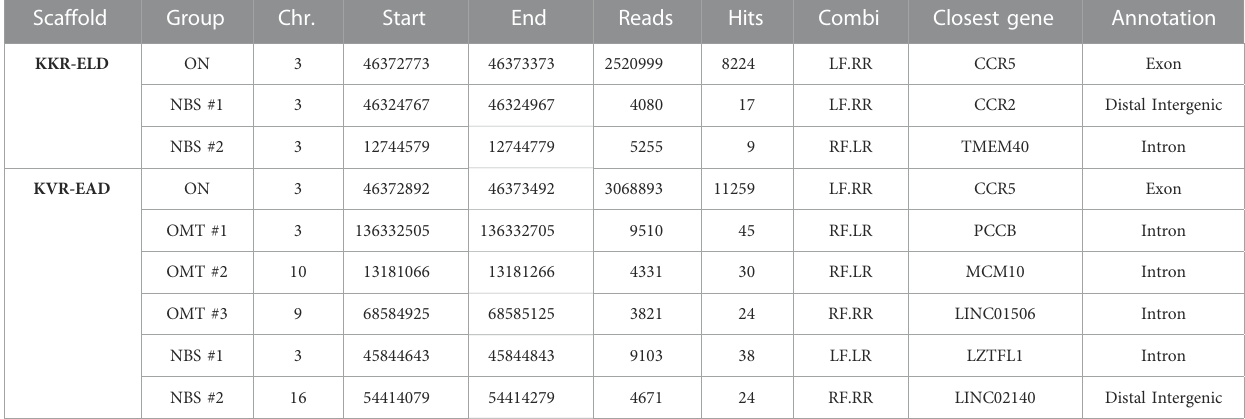
TABLE 3 T-CAST results for CCR5 -targeting OH-TALEN. Listed are OMTs with > 20 hits and the two top scoring NBSs. TALEN combinations: LF, left TALEN arm in forward orientation; LR, left TALEN arm in reverse orientation; RF, right TALEN arm in forward orientation; RR, right TALEN in reverse orientation. Scaffold Group